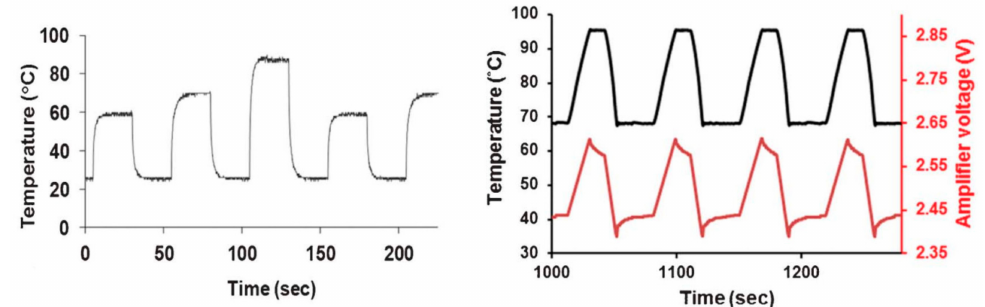
Figure 5. The changes of temperature in the heating well (chamber) with changing of the input signal amplitude (on left) and for various frequencies of the input voltage (on right) [61]. Reprinted from Marchiarullo, D.J.; Sklavounos, A.H.; Oh, K.; Poe, B.L.; Barker, N.S.; Landers, J.P. Low-power microwave-mediated heating for microchip-based PCR. Lab Chip 2013 , 13